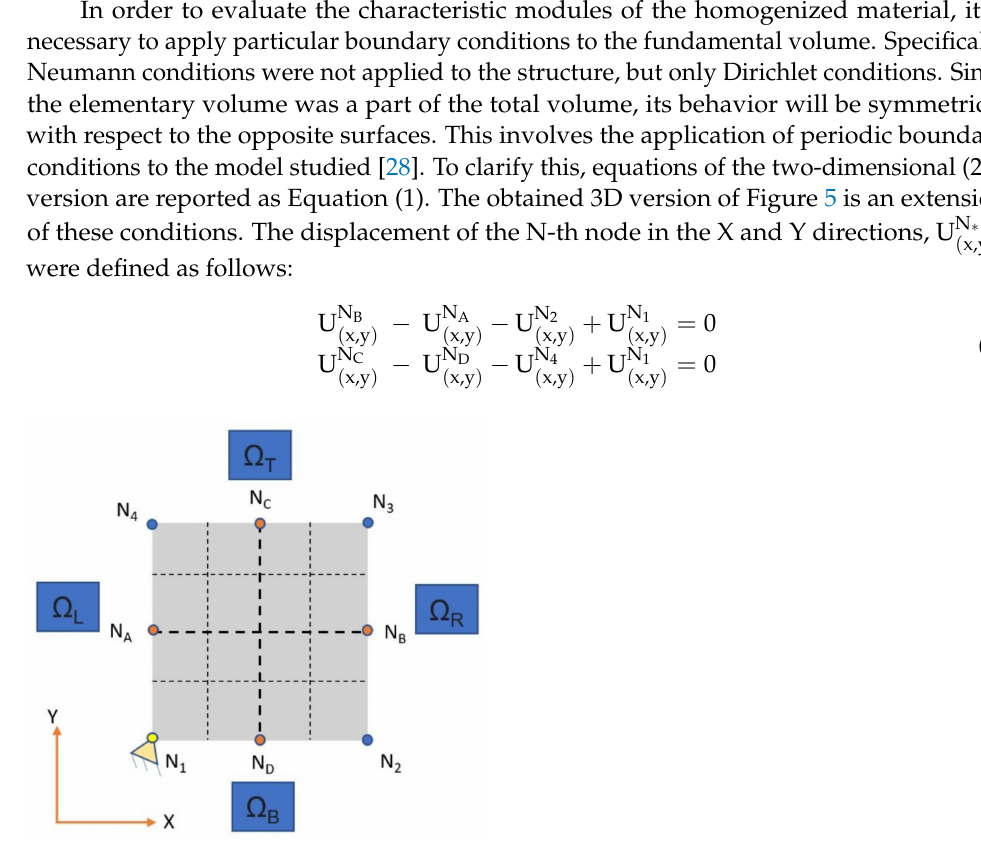
Figure 5. Two-dimensional (2D) RVE model for the application of boundary